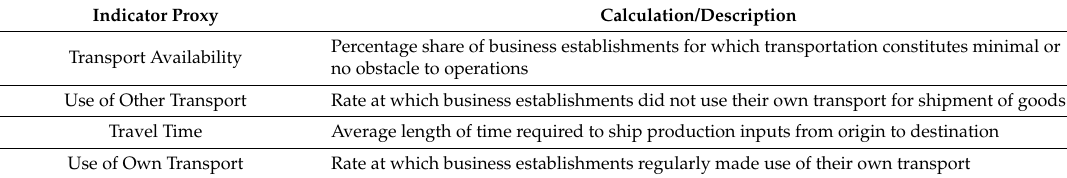
Table 2. Proxy Indicators for Transport.